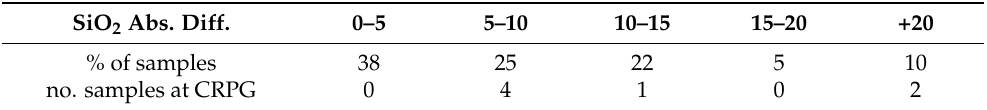
Table A3. Summary of the differences in silica content derived from ASTER GED using Equation (7) and measured in geochemical